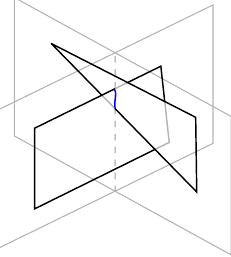
Figure 12: Intersection of the fitting planes of both polygons